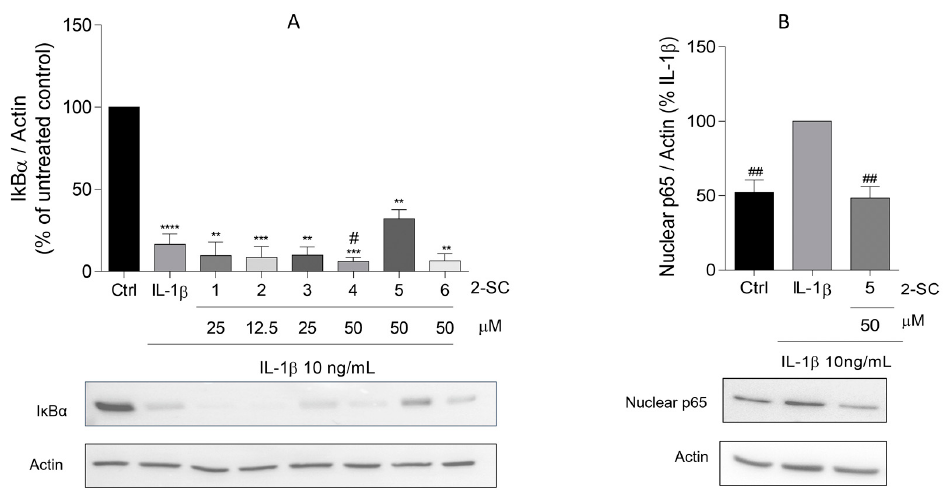
Figure 4. Effect of 2-Styrylchromones (2-SC) on IL-1 β -induced NF- κ B activation, evaluated as the levels of total I κ B- α ( A ) and nuclear p65 ( B ) on human fibroblast-like synoviocytes (HFLS) cells that were left untreated (control, Ctrl) or treated with IL-1 β (10 ng/mL), for 30 min, following pre-treatment for 30 min with the indicated concentrations of the 2-SC. Each column represents the mean ± SEM of 3 independent experiments. ** p < 0.01, *** p < 0.001, **** p < 0.0001 relative to Ctrl. # p < 0.05, ## p < 0.01 relative to IL-1 β treated cells.